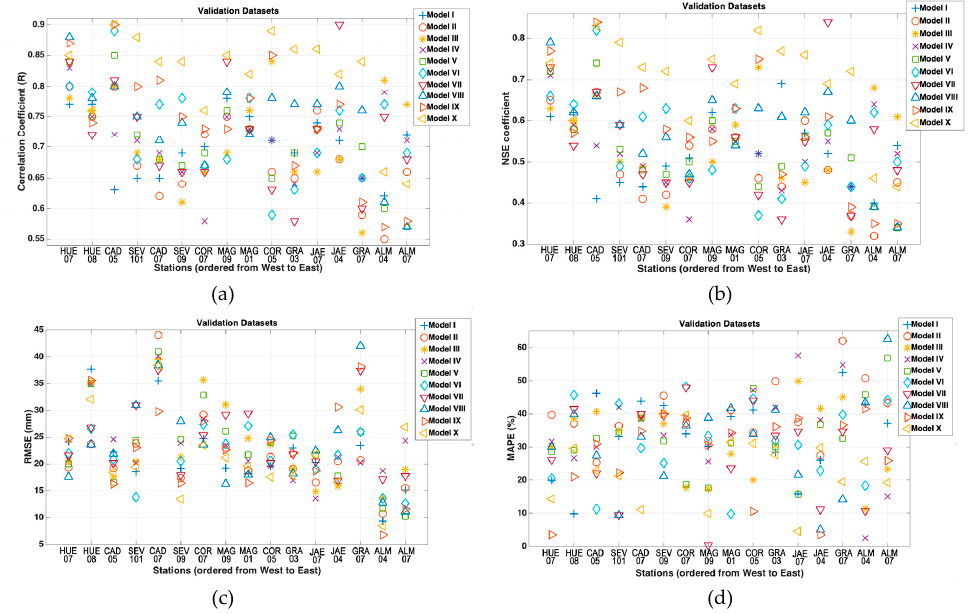
Figure 6. Results of the statistical performance obtained at each of the 16 locations studied: ( a ) R; ( b ) NSE; ( c ) RMSE; ( d ) MAPE.